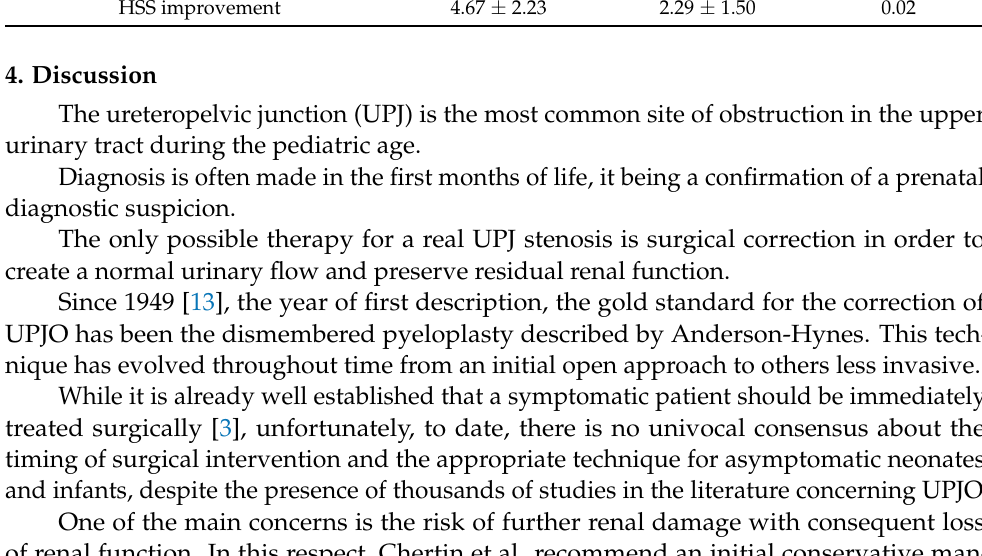
Table 3. “Hydronephrosis severity score” (HSS), before and at 1 year after surgery.